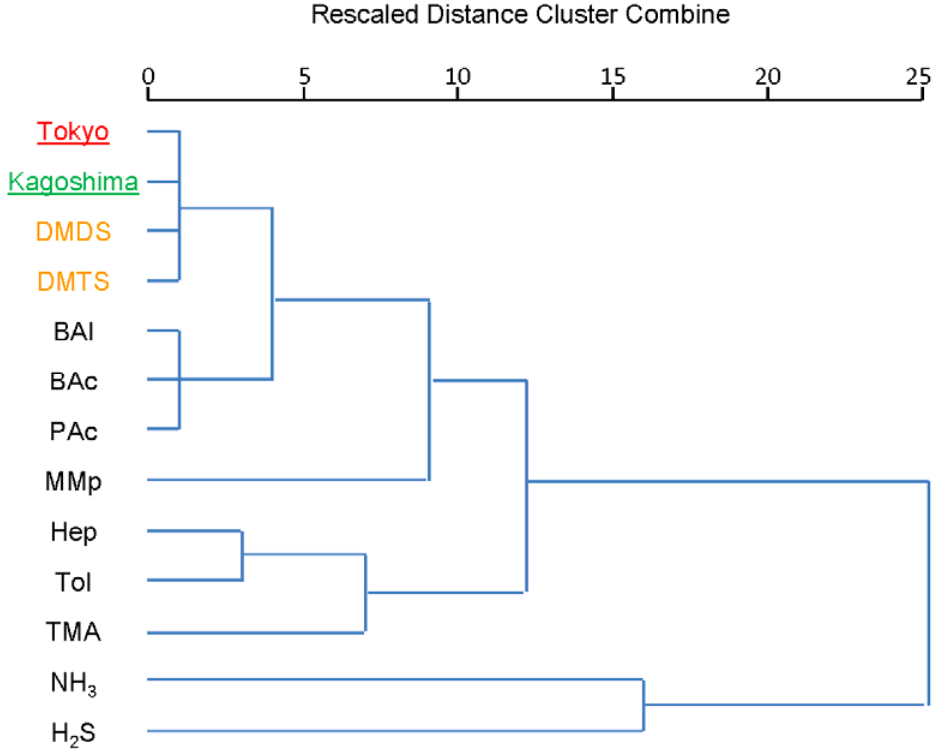
Figure 3. Cluster analysis (average linkage) of the discriminating power of the semiconductor sensors. A cluster analysis of titan arum odors from the 2 locations (Tokyo and Kagoshima), 9 standard gases and 2 principal components (0.01 ppm) was